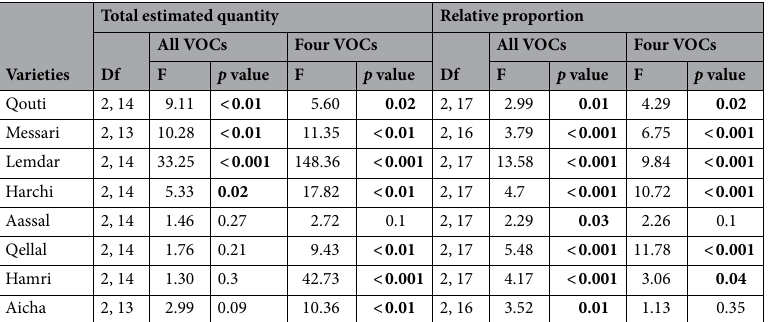
Table 3. Global results of the comparison among pollination periods of the total estimated quantity and on the relative proportions, of all volatile organic compounds (VOCs) and of the four pollinator-attractive VOCs emitted by figs of each variety. For the estimated quantity, analysis of deviance was performed on a linear regression model of VOCs (log-transformation). For the relative proportions, permutational multivariate analysis of variance (PERMANOVA) performed on proportions of VOCs (standardization prior to the analysis). Degrees of freedom (Df) and results of the test (F) are indicated. Significant p values ( p < 0.05) are indicated in